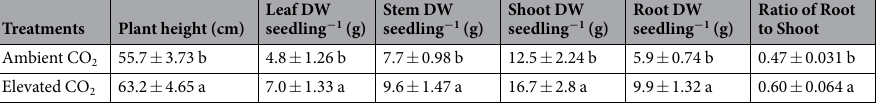
Table 1. Effect of elevated CO 2 concentration (800 µ mol mol − 1 for 24 d) on growth and biomass production in tea seedlings. Mean denoted by different letters indicate significant differences between the treatments ( P < 0 . 05 ). DW, Dry